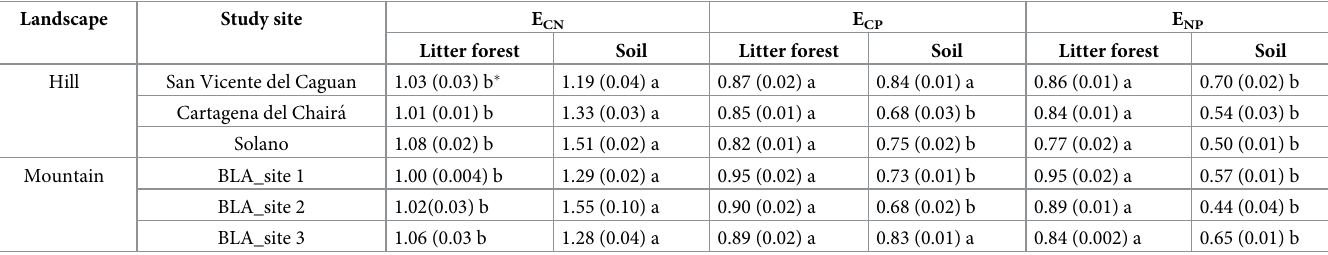
Table 4. Stoichiometry enzymes activity in forest litter and soil in Colombian Amazon region.